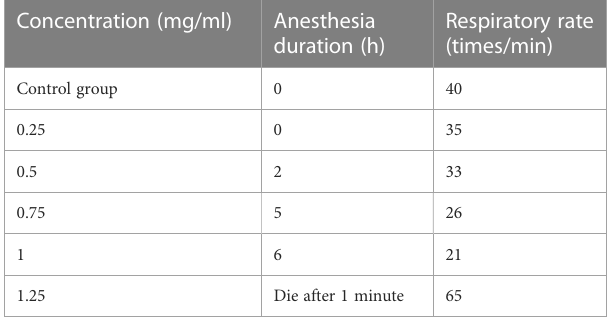
TABLE 3 Gallamine triethiodide injection physiological response